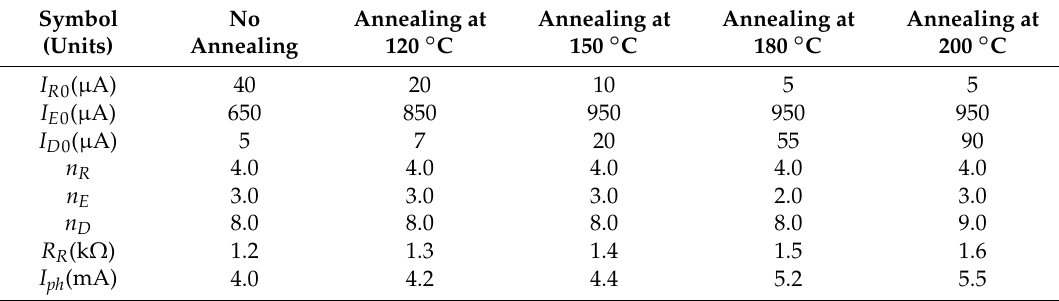
Table 2. Model parameters used in simulations of our previous model [17] in Figure